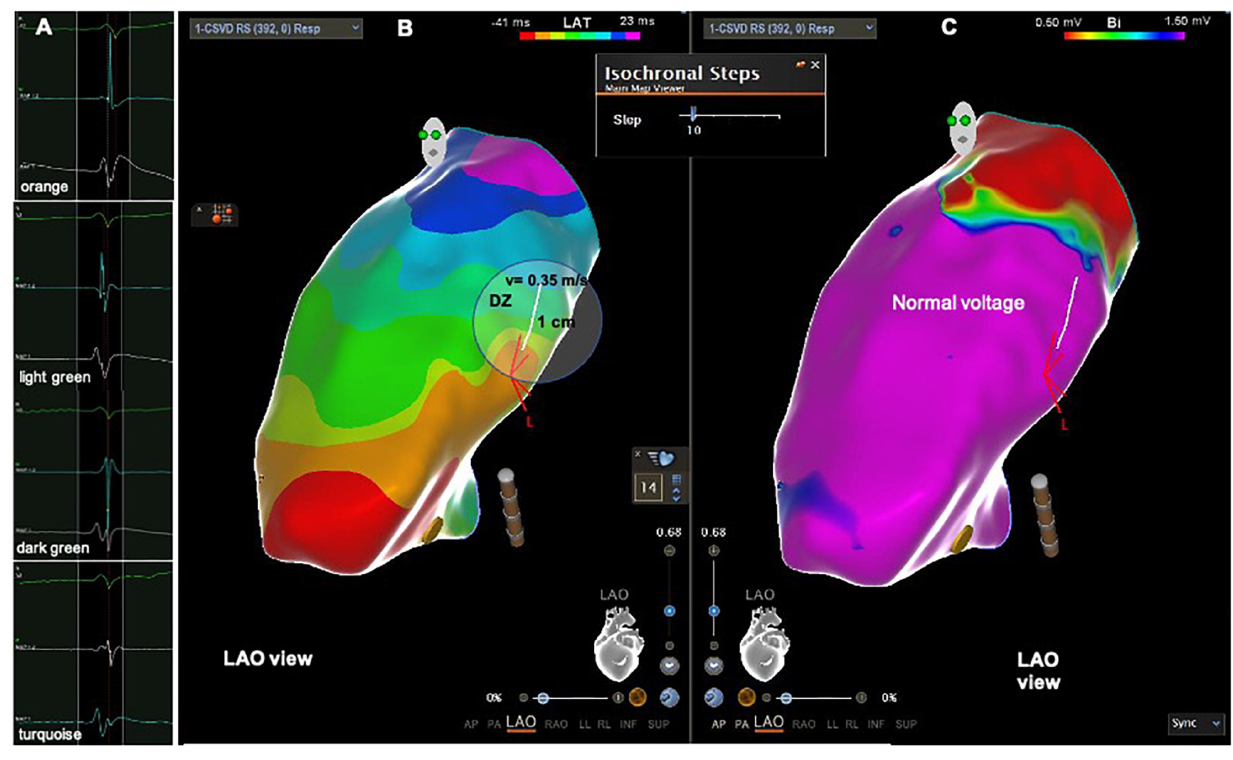
FIGURE 4 | Patient from the PVC group with DZ outside the LVAs. (A) Intracardiac electrograms corresponding to the respective isochrones presented in the isochronal map. (B) RVOT isochronal map in sinus rhythm with DZ in the RVOT free wall. (C) Voltage map in sinus rhythm with normal voltage at the DZ. DZ, deceleration zone; LVA, low voltage area; RVOT, right ventricular outflow